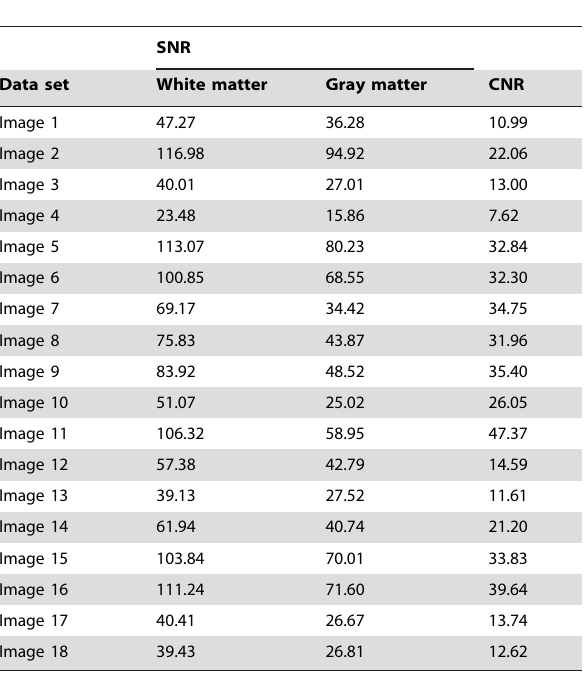
Table 2. Image quality parameters of the IBSR data set.